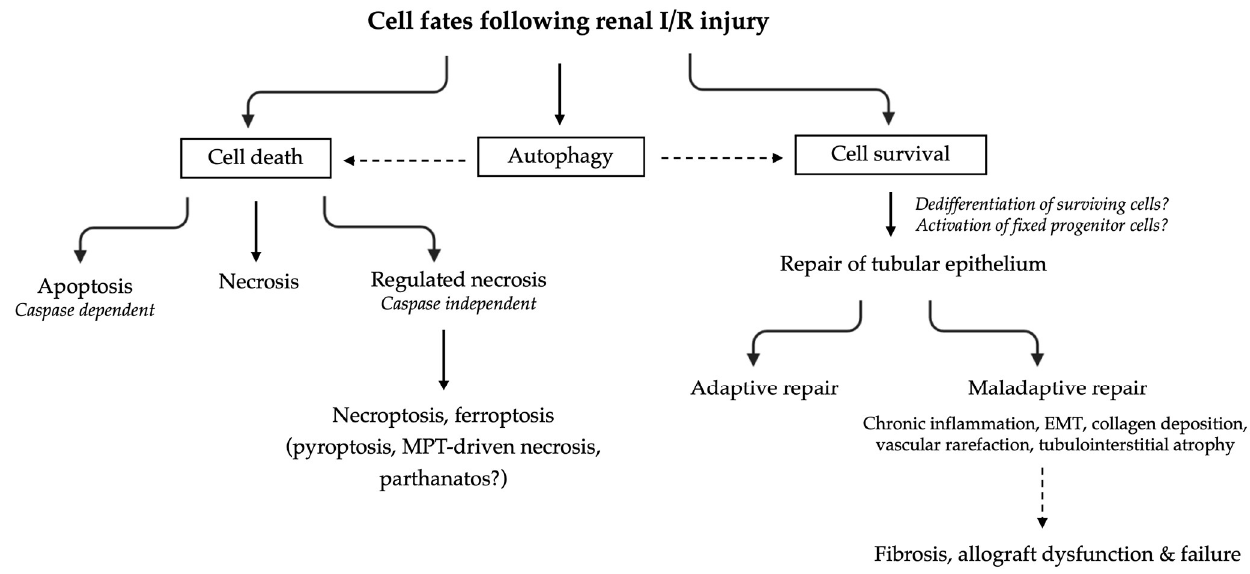
Figure 3. Possible cell fates following ischemia–reperfusion injury. MPT, mitochondrial permeability transition; EMT, epithelial-to-mesenchymal transition .